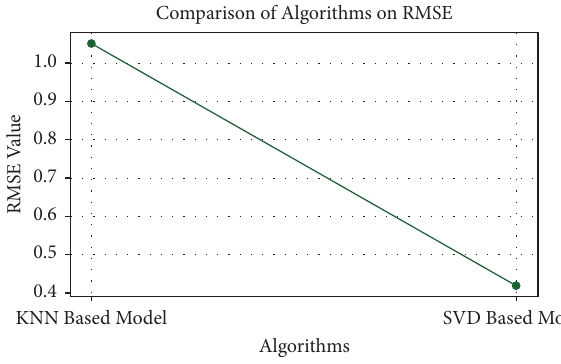
Figure 7: Te comparison of algorithms on RMSE.